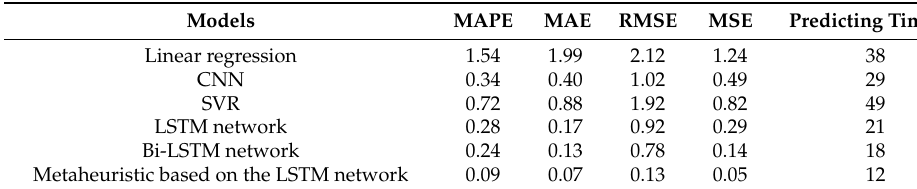
Table 3. Performance of the experimental models on the AEP dataset.